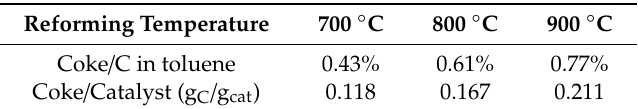
Table 2. Toluene conversion to coke and fraction of coke deposited on the catalyst at di ff erent